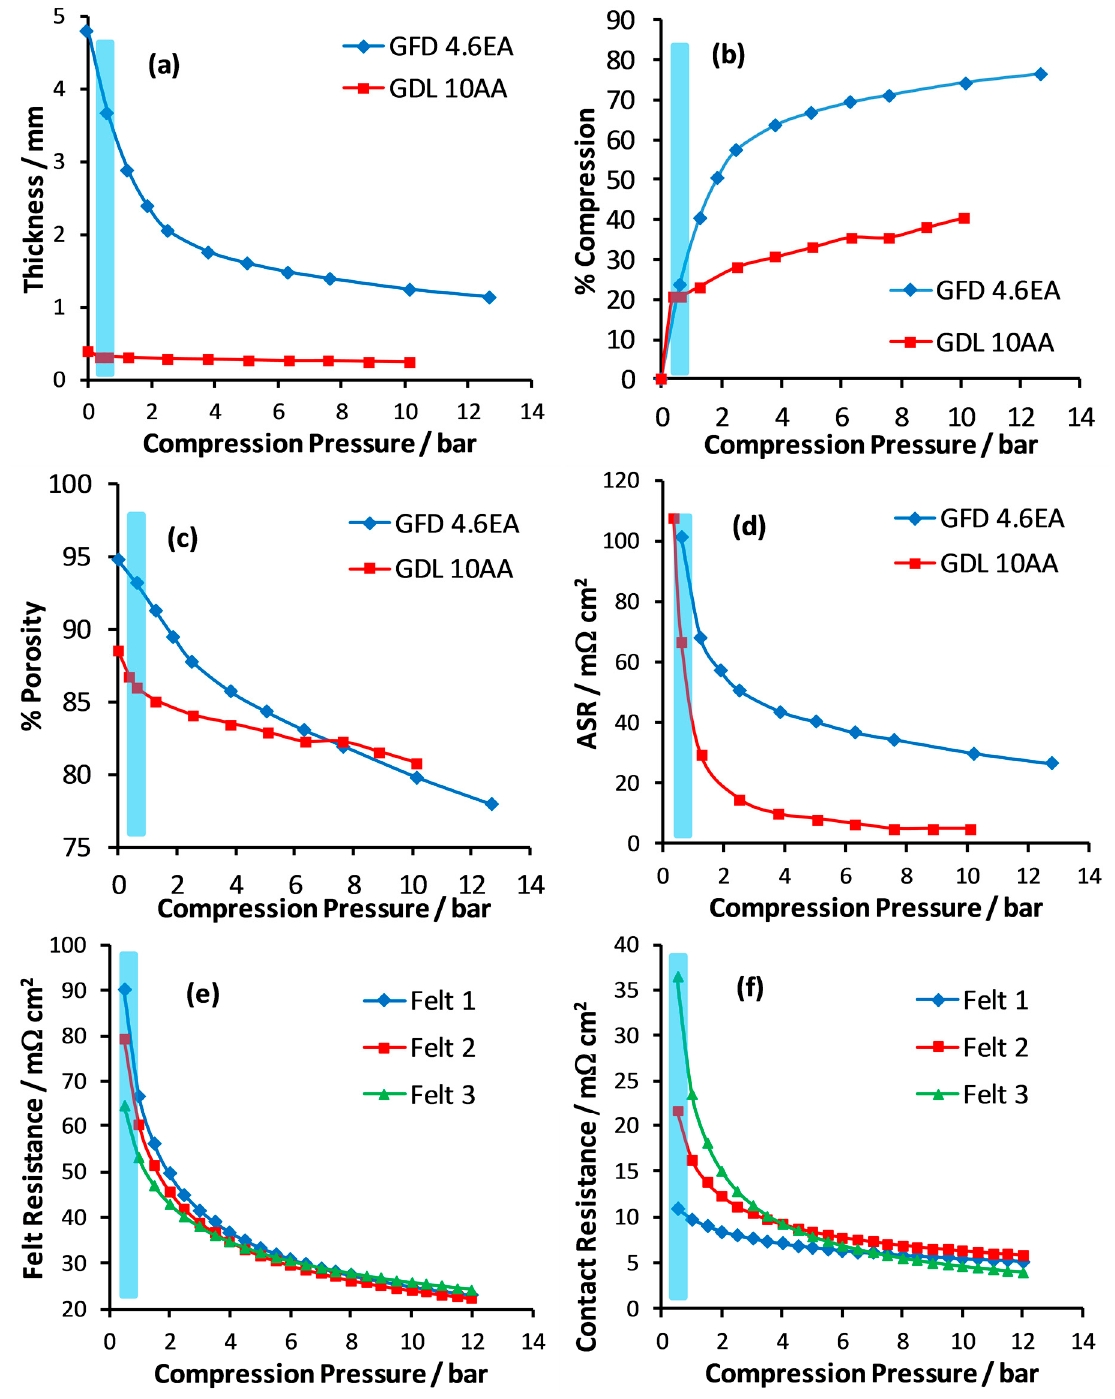
Figure 1. Plots of ( a ) thickness, ( b ) compression, ( c ) porosity and ( d ) total area specific resistance against compression pressure for samples of GFD 4.6EA and GDL 10AA. ( e ) Bulk felt area specific resistance and ( f ) total area specific contact resistance vs. compression pressure for samples of GFD 4.6EA. Blue zone represents the 10–30% felt compression range.